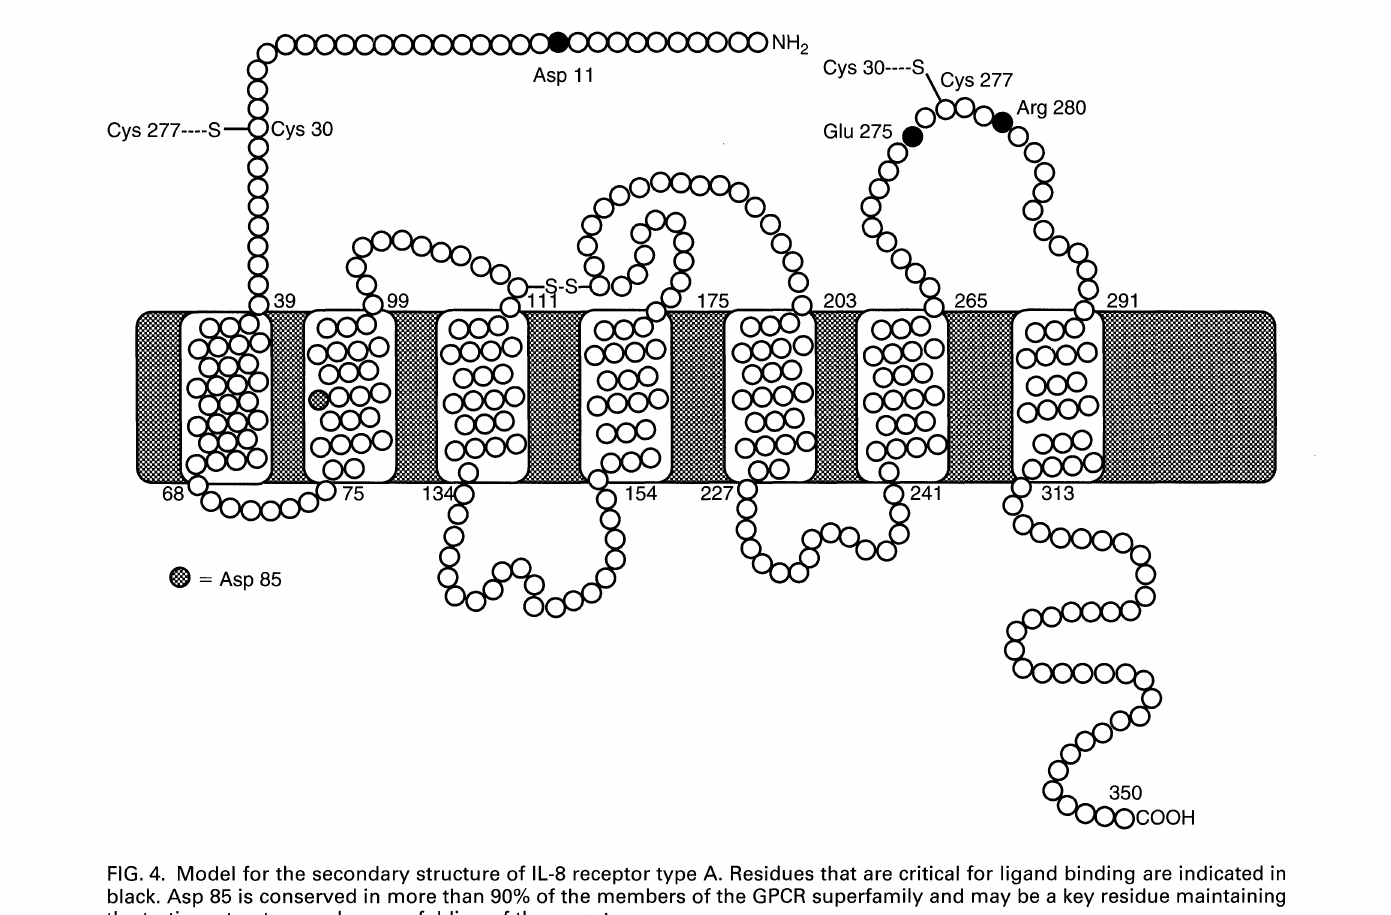
FIG. 4. Model for the secondary structure of IL-8 receptor type A. Residues that are critical for ligand binding are indicated in black. Asp 85 is conserved in more than 90% of the members of the GPCR superfamily and may be a key residue maintaining the tertiary structure and proper folding of the